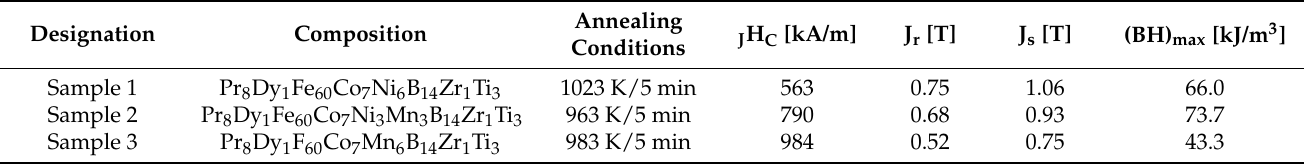
Table 2. Basic magnetic properties and processing parameters for the examined ribbons.